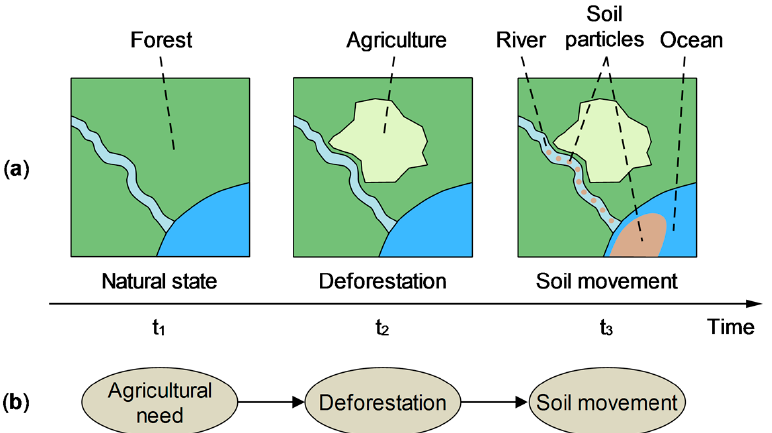
Figure 14. Example of deforestation, chain of causal relations , ( a ) representation of the real-world entities, ( b ) sequences of causes (ovals) and their causal relations (arrows).